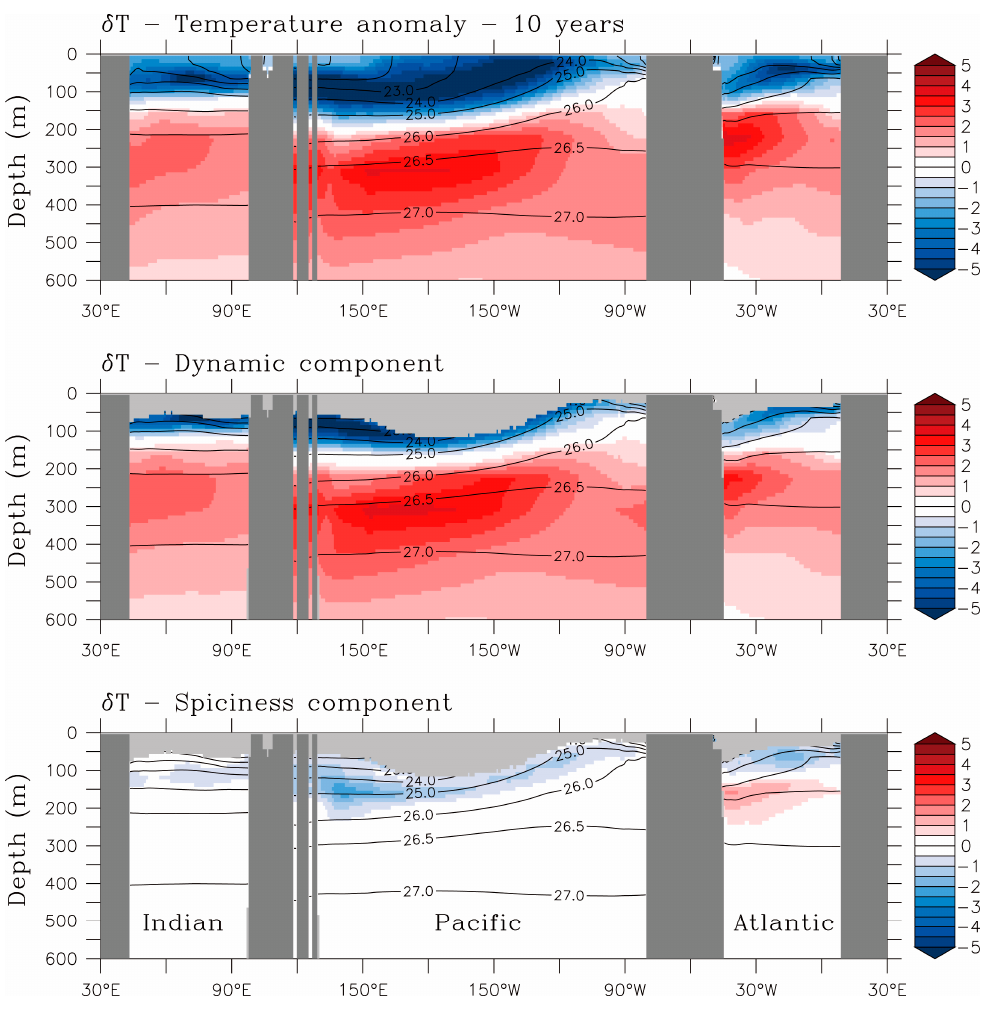
Figure 6. Same as Figure 5 except that it is after 10 years of OTEC activity, and that the color scale has a 0.5 °C constant increment.